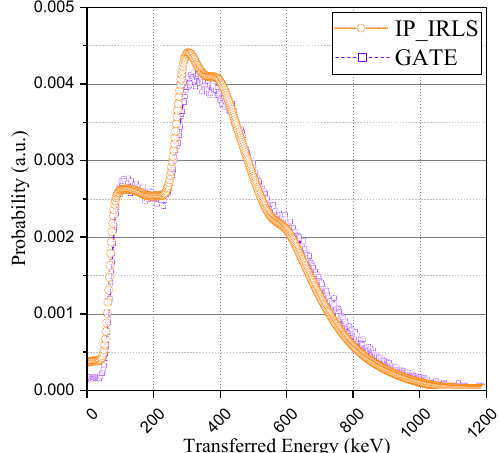
Figure 9. Comparison with GATE simulation ( 176 Lu ion source).